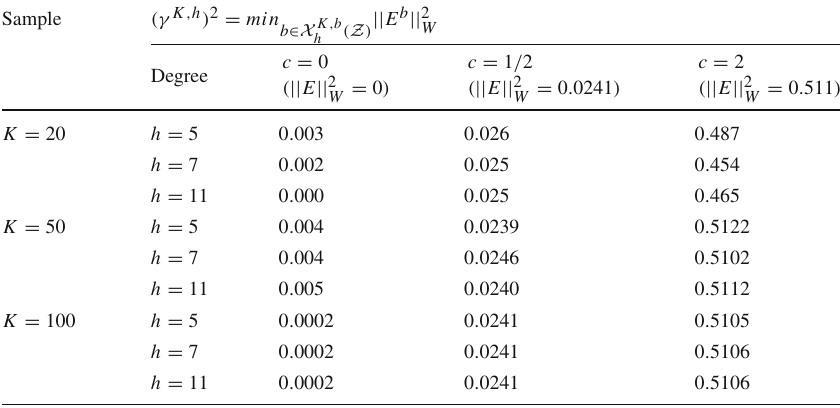
Table 2 Numerical approximation of the square of the minimal Slutsky norm of a set of extensions, for different sample size and different size of functional space of interpolators